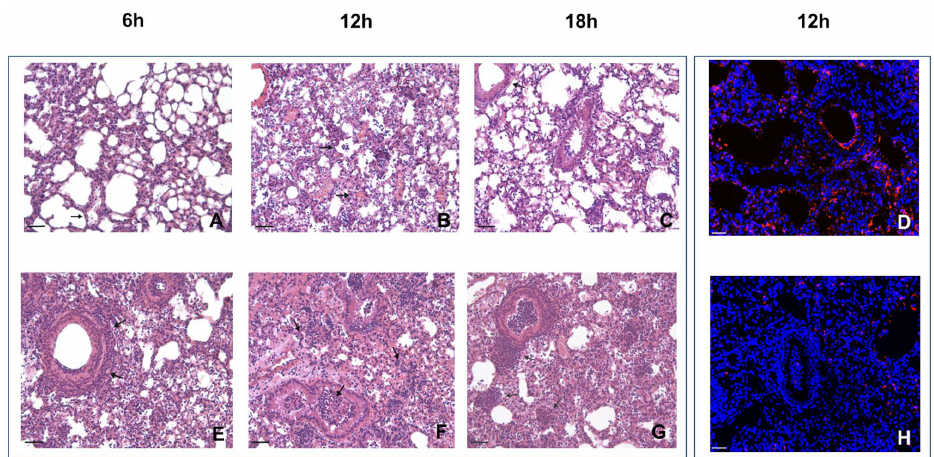
Figure 5. Histopathology in susceptible A/J and resistant C3H/HeOuJ P . aeruginosa -infected mice. The lungs of A/J ( A–D ) and C3H/ HeOuJ ( E–H ) were stained with H&E ( A–C, E–H ) and in immunofluorescence with specific antibody against P. aeruginosa (red) ( D, H ). Counterstaining was performed with 49,6-Diamidino-2-phenylindole dihydrochloride (DAPI) (blue). After time course analysis, extensive infection and inflammation were visible in murine lungs with major differences between A/J and C3H/HeOuJ. Arrows indicate aggregates of lynphocytes infiltrates. Bars, 200 m m for H&E images, 100 m m for immunofluorescence images. Severity of lesions and lung involvement was scored as reported in Fig S4 .